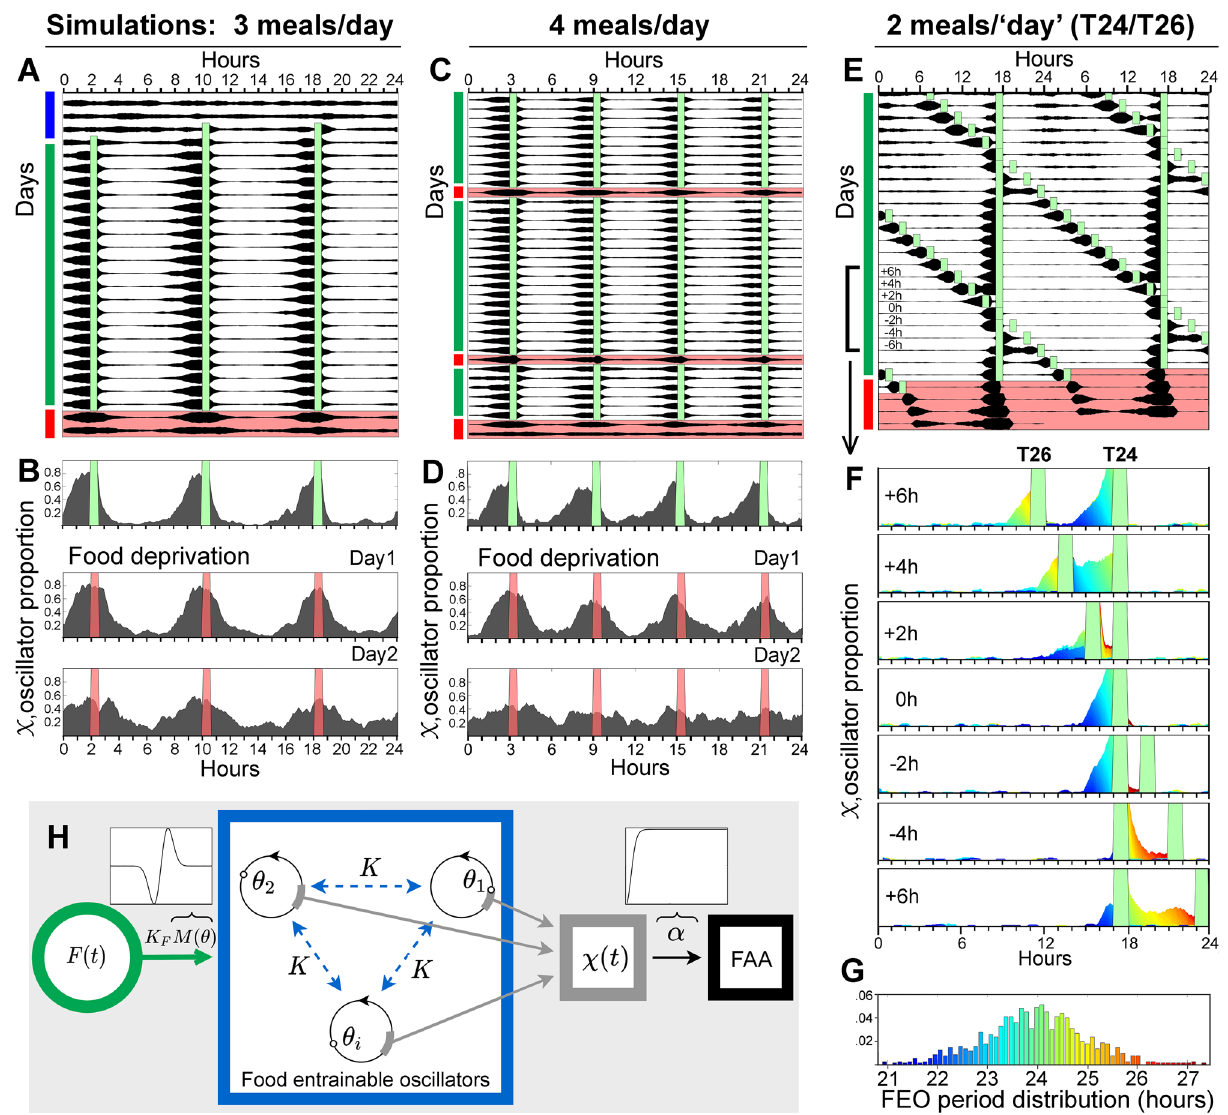
Figure 5. A Kuramoto model simulates food anticipatory activity rhythms. Actograms and running waveforms showing predicted activity α( χ ) of multiple FEOs in response to 3 daily meals ( A , B ) 4 daily meals ( C , D ), and 2 daily meals provided at different periodicities (24 h and 26 h, E ). Plotting format as in Fig. 1a. Green bars denote mealtimes. Red bars and pink shading denote expected mealtimes during a 2 or 3-day food deprivation test. ( F ) Waveforms illustrating the phase FEO oscillators colored by intrinsic periods during concurrent T24 and T26 meal schedules. Oscillators with periods > 24 h entrain to the 26 h meal and oscillators with periods < 24 h to the 24 h meal. ( G ) Frequency distribution and color-coding of FEO periodicities within the 21–28 h range. ( H ) Diagram of components of the quantitative model (see "Methods" for